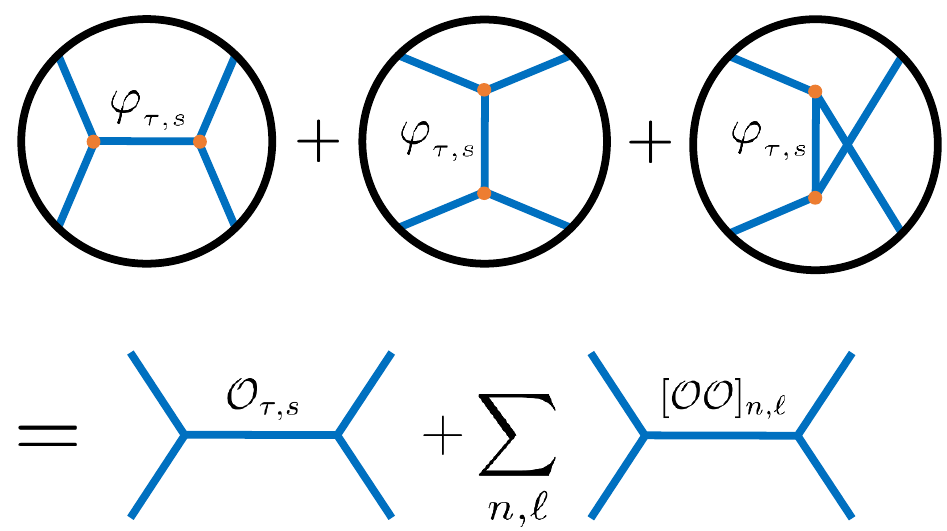
Figure 1. The form of the CFT conformal block decomposition of the complete crossing-symmetric AdS amplitude due to ’ (cid:28);s exchange. O is the boundary operator on the external legs, and O (cid:28);s is the operator dual to ’ (cid:28);s . In this paper, we solve for the right-hand side of this equation using CFT crossing symmetry at large N